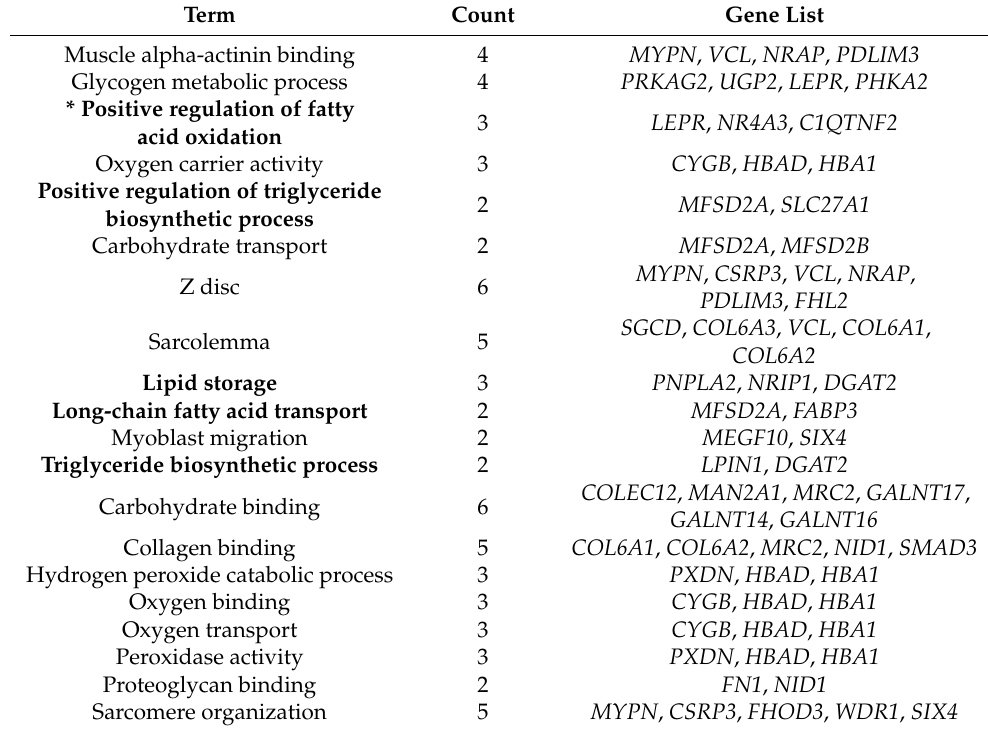
Table 3. GO terms potentially related to leg muscle quality and meat flavor changes. Term Count Gene